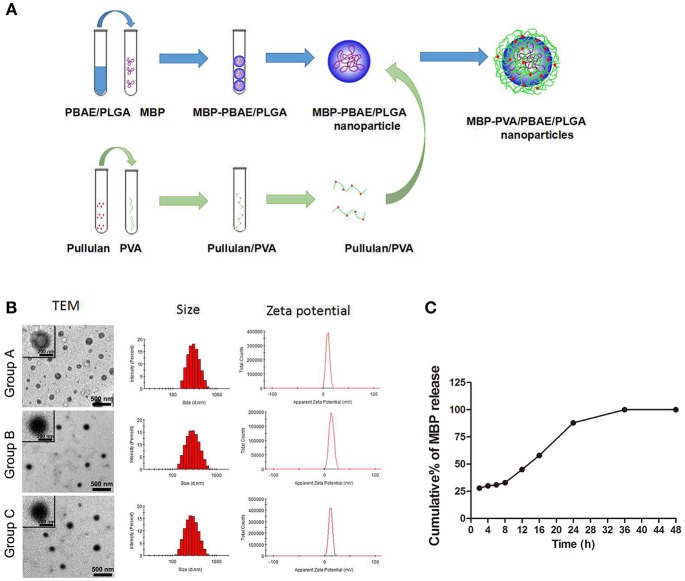
(A) Synthesis flow diagram of PVA/PBAE/PLGA nanoparticles loaded with MBP. (B) Transmission electron microscopy determinations of the particle sizes and charge characteristics of the PVA/PBAE/PLGA nanoparticles loaded with different brain antigens. Group A: PVA/PBAE/PLGA nanoparticles loaded with normal saline. Group B: PVA/PBAE/PLGA nanoparticles loaded with MBP. Group C: PVA/PBAE/PLGA nanoparticles loaded with brain proteins. (C) The release profiles of MBP from the PVA/PBAE/PLGA nanoparticles.